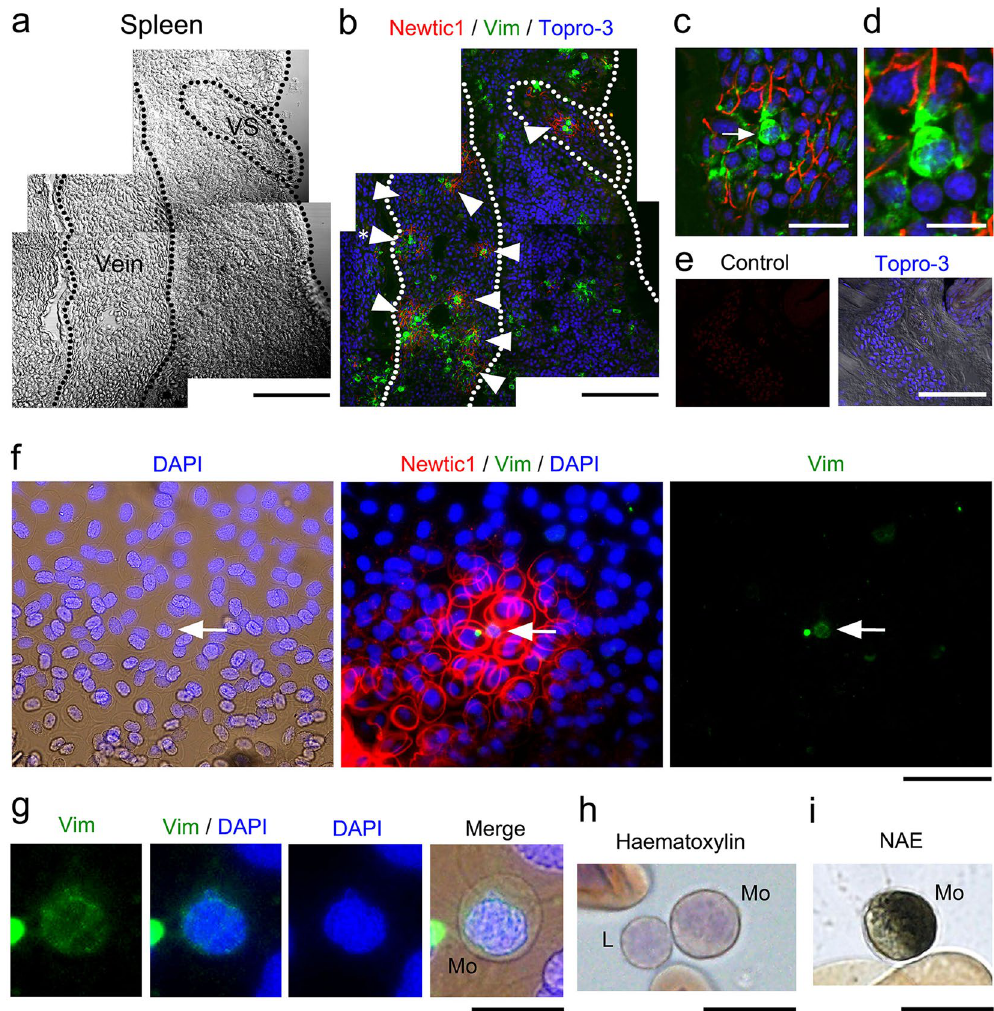
Figure 3. Newtic1-expressing erythrocytes form an aggregate structure EryC, which is accompanied by monocytes and circulating throughout the body. ( a – d ) Representative images showing EryCs in the spleen (n = 3). ( a ) A section of the spleen. VS: Venus sinus. Scale bar, 200 μ m. ( b ) Immunofluorescence labeling of the same section with Newtic1 antibody (red) and vimentin antibody (green). Arrowheads point EryCs. Topro-3: nucleus. Scale bar, 200 μ m. ( c ) Enlargement of EryCs (asterisk in b ). EryCs were accompanied by spherical cells with vimentin-immunoreactivity (arrow). Scale bar, 40 μ m. ( d ) Enlargement of a spherical cell (arrow in c ). Scale bar, 40 μ m. ( e ) Negative control for the immunofluorescence labeling of blood-containing vessels (n = 3). Control: labeling with RFP antibody (red). Topro-3: nucleus. Scale bar, 200 μ m. ( f , g ) Vimentin- immunoreactive (Vim + ) cells in EryCs. ( f ) Immunofluorescence labeling of blood cells with Newtic1 antibody (red) and vimentin antibody (green). Peripheral blood was collected in a plastic dish and allowed to coagulate to preserve the structure of EryCs. Newtic1-immunoreactivity was only observed in PcNobs of EryCs, but not in free PcNobs scattered around EryCs. Arrow: Vim + cell. DAPI: nucleus. Scale bar, 80 μ m. ( g ) Enlargement of the Vim + cell (arrow in f ). Vim + cells were 16–20 μ m in diameter and had a brain-shaped nucleus surrounded by vimentin. From these morphological characteristics, Vim + cells were identified as monocytes (Mo; see below). Note that Vim + cells in blood were always monocytes. Scale bar, 20 μ m. ( h ) Representative image of haematoxylin stain of the adult newt monocyte (Mo) and lymphocyte (L). Scale bar, 20 μ m. ( i ) Example image of adult newt monocytes identified by α -naphthyl acetate esterase (NAE) activity in their cytoplasm. Scale bar, 20 μ